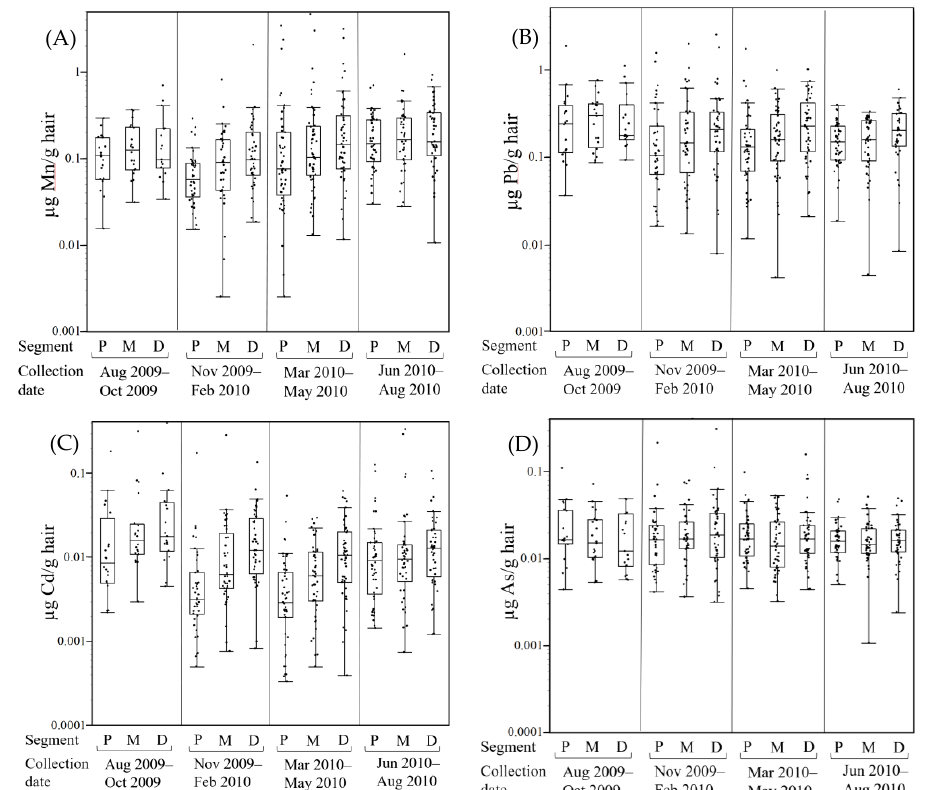
Figure 3. Hair segment Mn ( A ), Pb ( B ), Cd ( C ), and As ( D ) levels in females (µg/g, note log scale) vary with season of collection. Hair metal levels are plotted by three to four months season of collection intervals. The horizontal line within the box represents the median, while the upper and lower margins of the boxes represent the 75th and 25th percentiles; the whiskers are drawn to the furthest data point within 1.5 times the interquartile range. Only female subjects with proximal (P), medial (M), and distal (D) hair segments are shown ( n = 153 – 155 subjects per metal). We similarly performed mixed model analysis restricted to metal levels in the proximal segments of males and females, with sex and season of collection as fixed effects and subject as a random effect. Results show a significant effect of sex ( p ’s < 0.0001) and season ( p ’s ≤ 0.004) on proximal segment Mn, Pb, and Cd levels, with higher metal levels in males and higher levels in hair collected in summer/early fall versus winter/spring. For proximal segment As levels, there was a significant effect of sex ( p < 0.0001, males higher), but no effect of season of hair collection ( p = 0.137). There was no sex – season interaction for any of the metals ( p ’s > 0.43), indicating that the season of collection did not differently affect male and female hair metal levels.